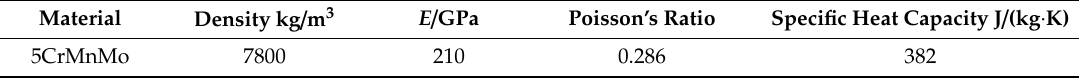
Table 6. Thermomechanical properties of the dye materials.